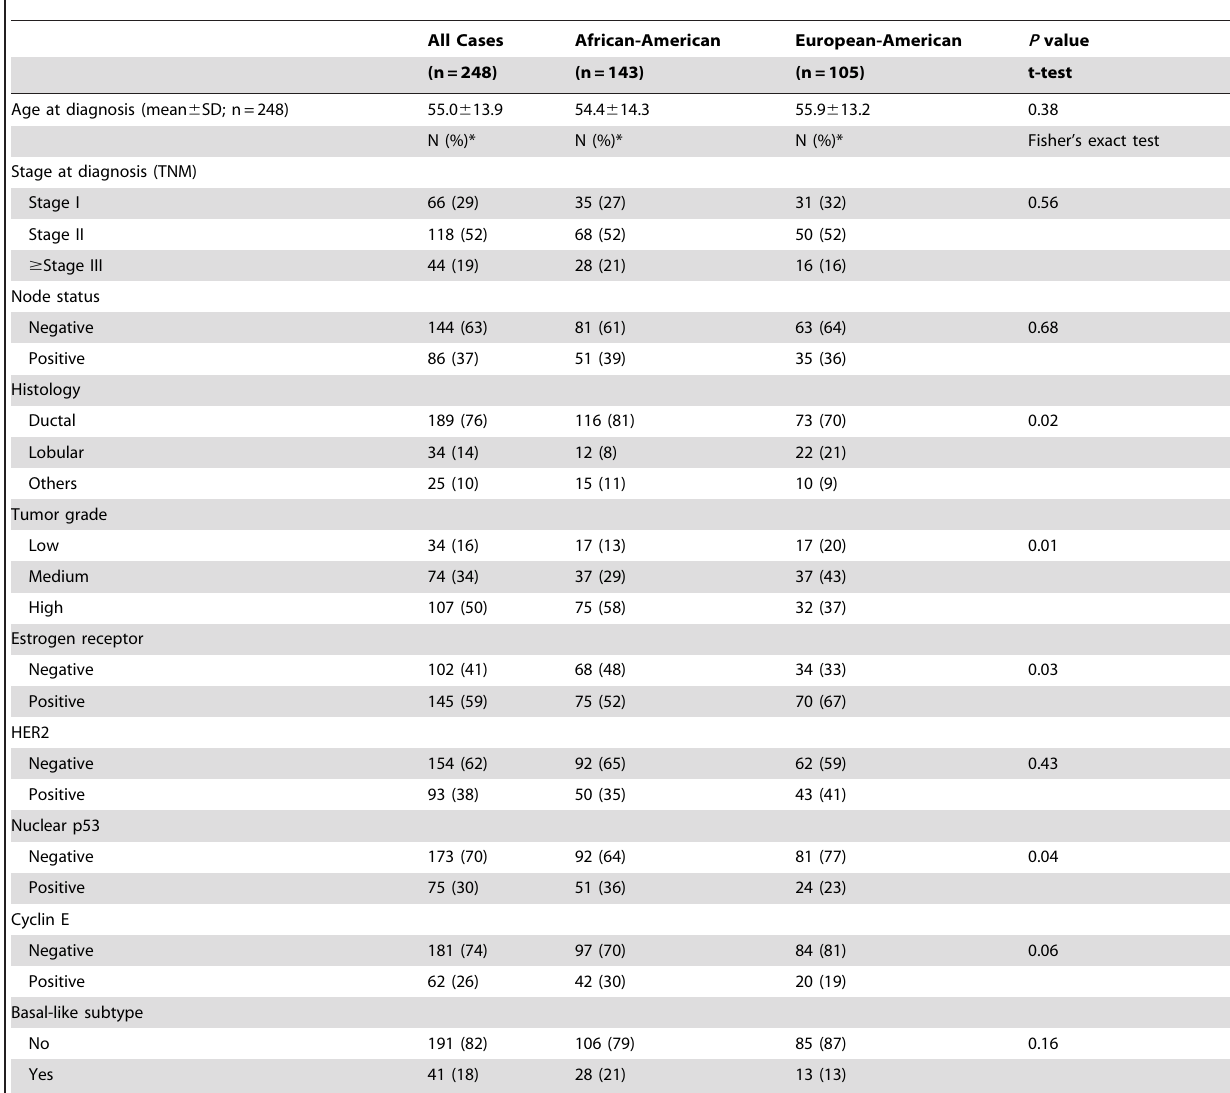
Table 1. Clinical characteristics of the study